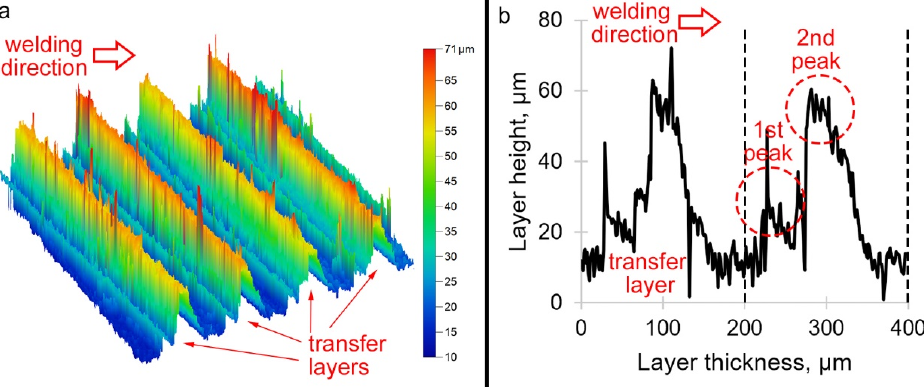
Figure 1. Typical 3D image of the friction surface ( a ) and 2D profile of the transfer layers ( b ).